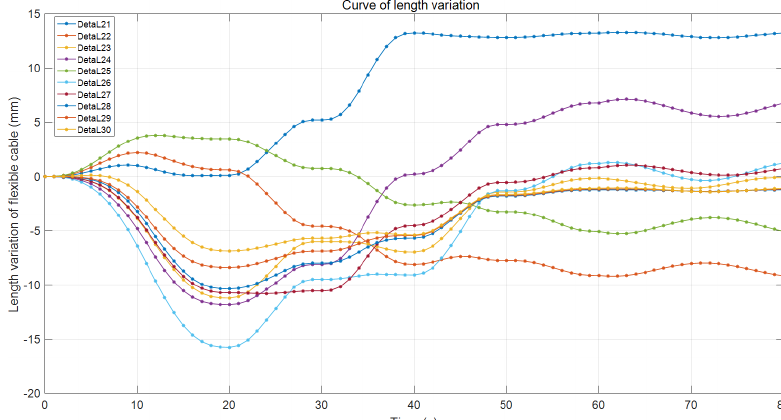
Figure 11. Flexible cable length variation curves (3).